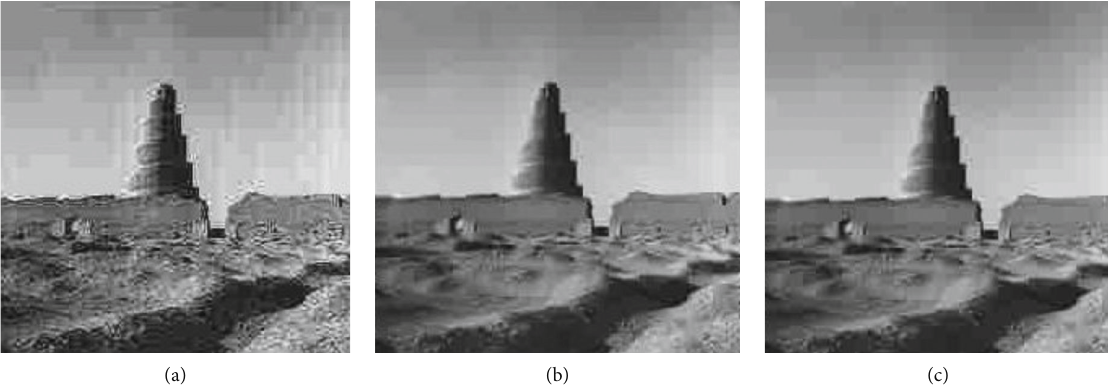
Figure 7: Test image left to right: (a) JPEG, (b) JPEG 2000, and (c) EED (0.2 bpp). It is a large mosque that was built in the ninth century by Al-Mutawakkil, the ruler of the Abbasid Empire in the city of Samarra/Iraq.